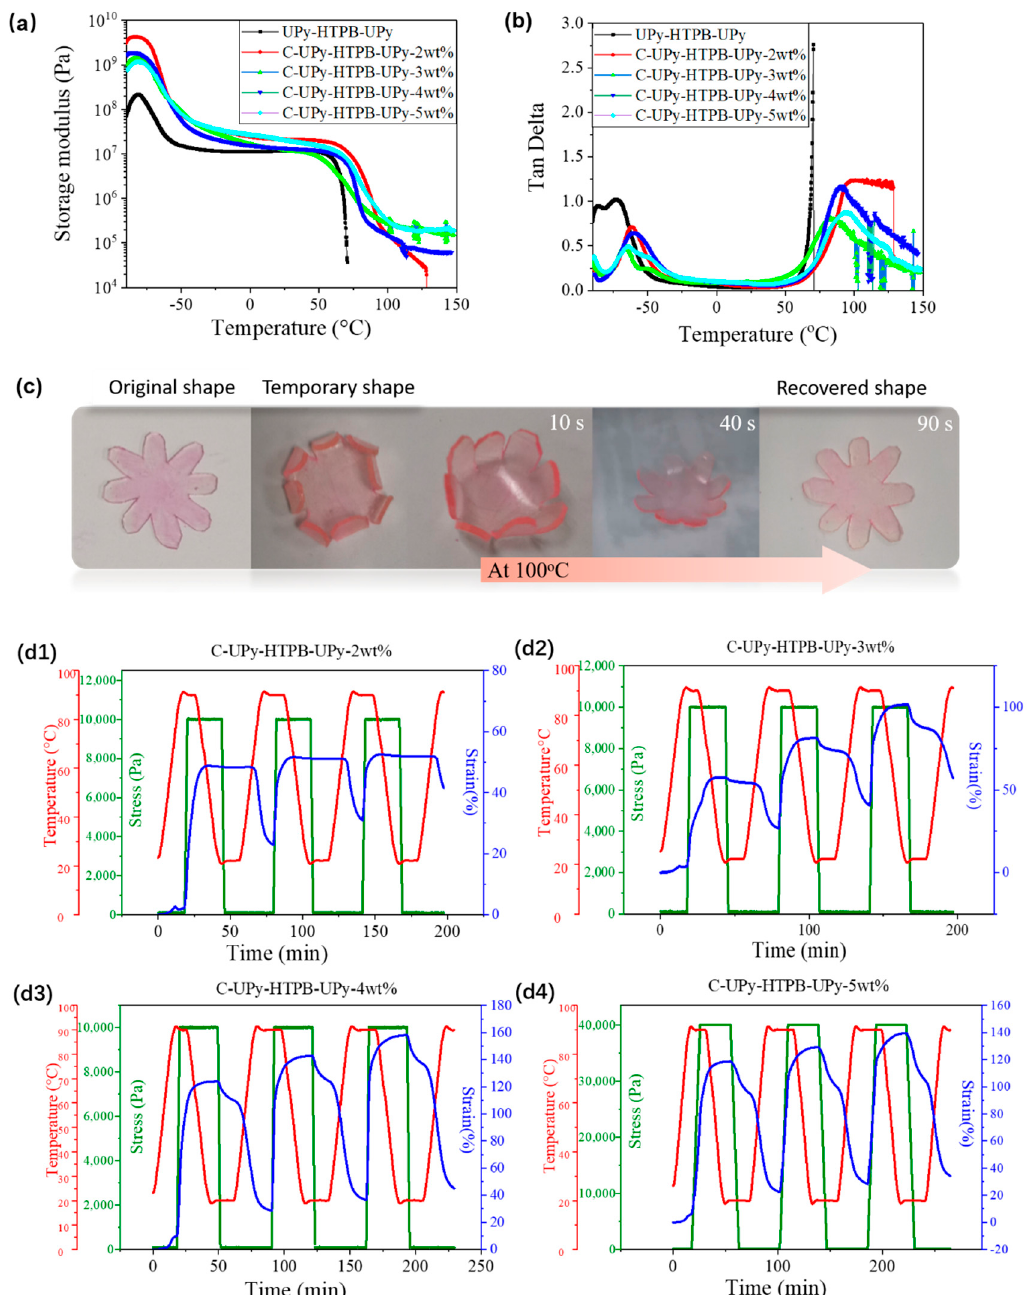
Figure 5. DMA results of ( a ) storage modulus and ( b ) tangent delta. ( c ) Shape memory effect of C-UPy-HTPB-UPy-4 wt% (rhodamine staining to color the material into red) and ( d1 – d4 ) three shape memory cycles of C-UPy-HTPB-UPy- n wt%, n = 2, 3, 4 and 5 (via